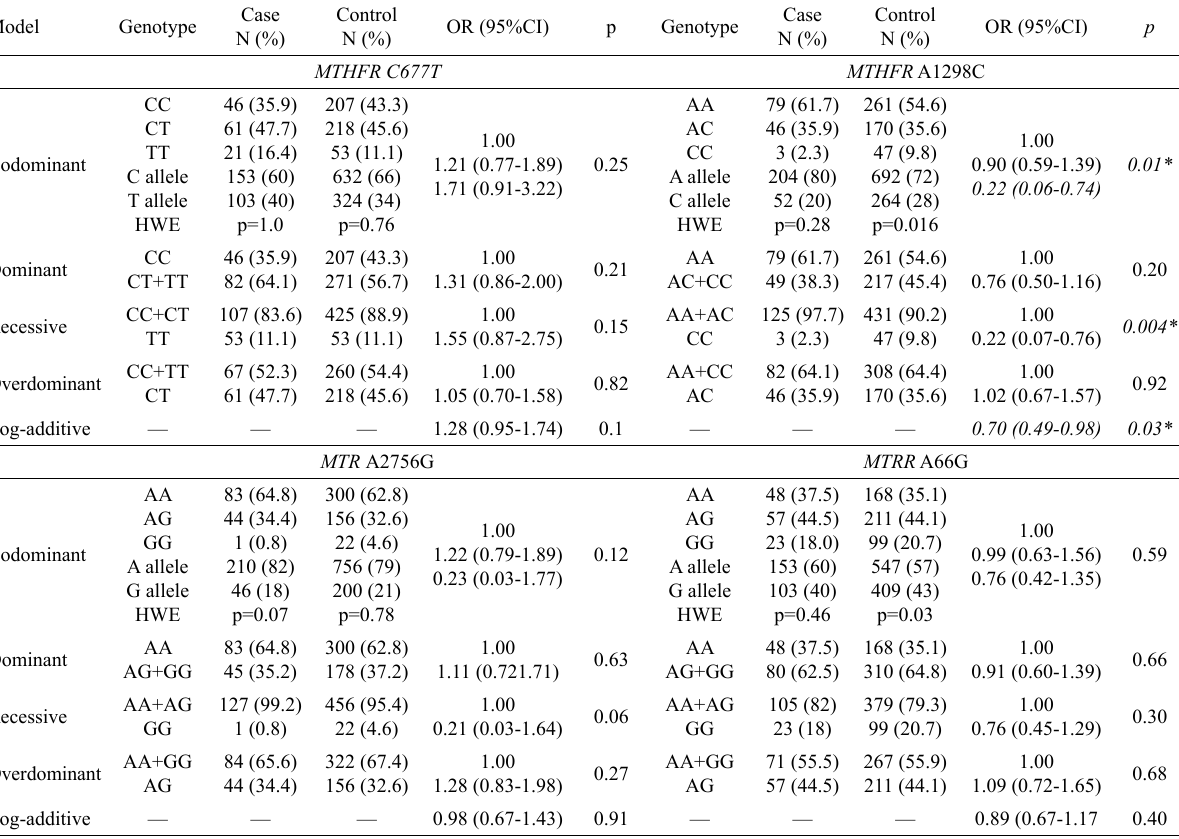
Table 4 ‒ Analyzis of MTHFR C677T, MTHFR A1298C, MTR A2756G and MTRR A66G polymorphisms with breast cancer.